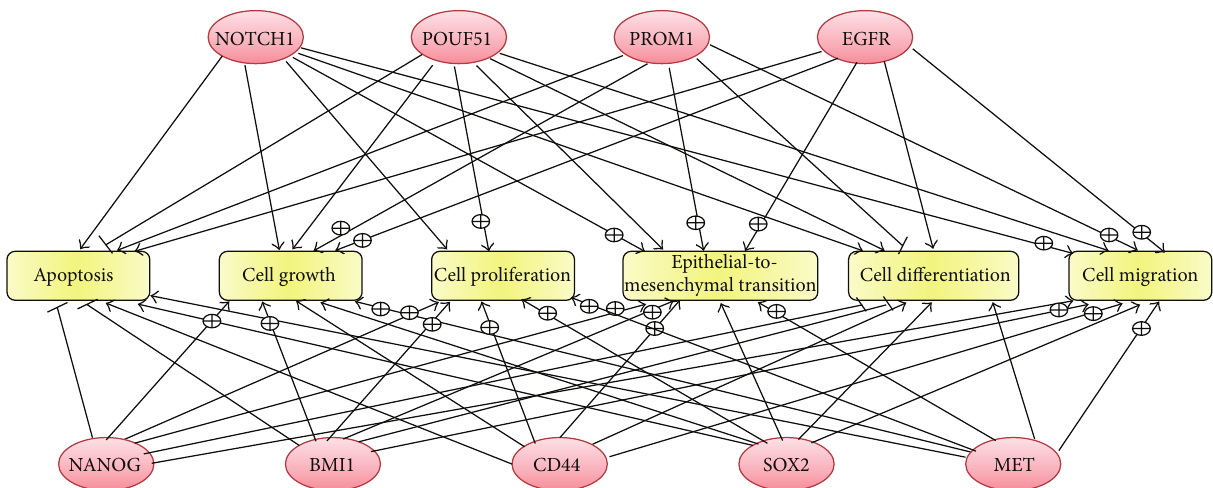
Figure 3: Cellular processes common to all nine cancer stem cell- (CSC-) associated genes. Pathway Studio was used to identify known relationships and cellular processes that are common between the CSC-associated genes. The ⨁ symbol on the arrow represents positive regulation of the process whilst a – through the arrow represents negative